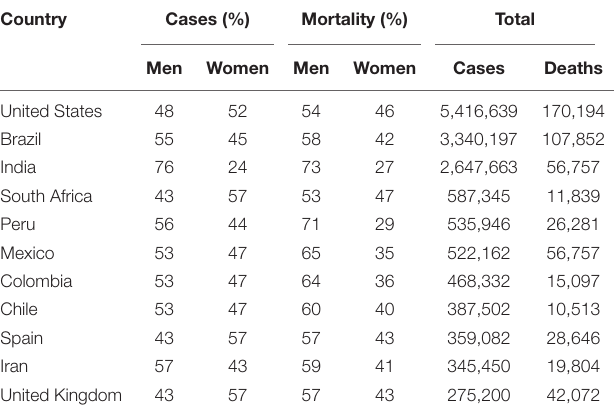
TABLE 1 | Gender-based differences in COVID-19 case and mortality rates. Country Cases (%) Mortality (%) Total Men Women Men